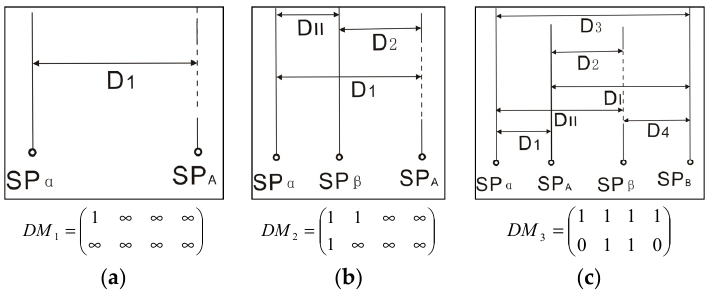
Figure 7. Three typical DS8DMs. ( a ) The DS8DM between two SSLs; ( b ) the DS8DM between one SSL and one DSL; ( c ) the DS8DM between two DSLs. and one DSL; ( c ) the DS8DM between two